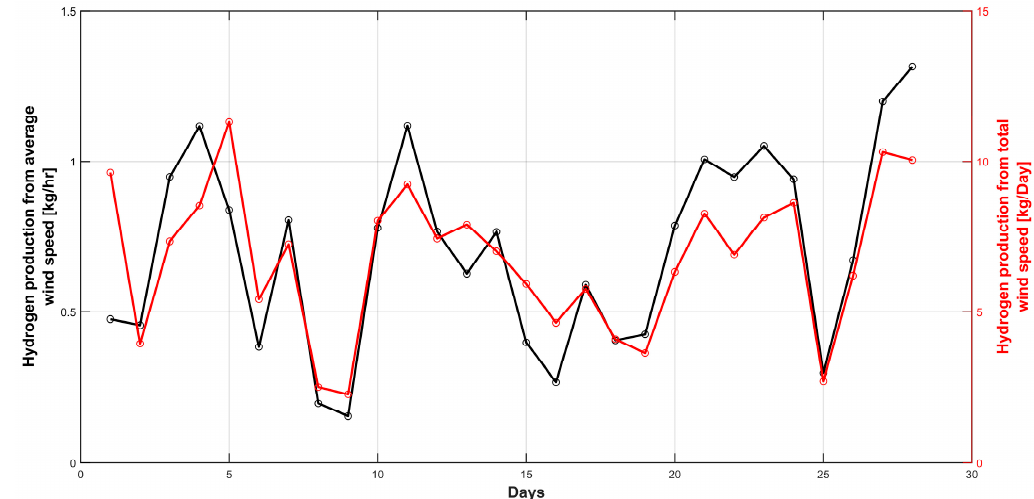
Figure 9. Average hydrogen production and total hydrogen production.